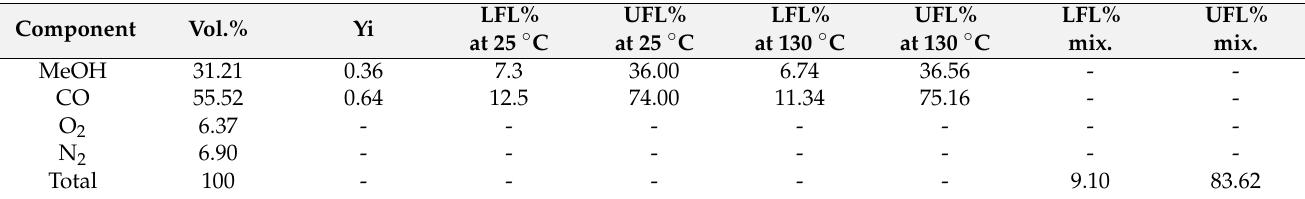
Table 2. Results of flammability analysis for reactor